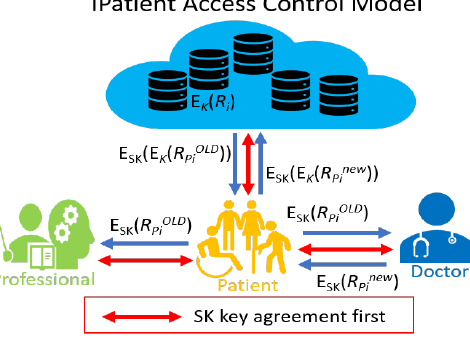
Figure 3. Our iPatient access control model.